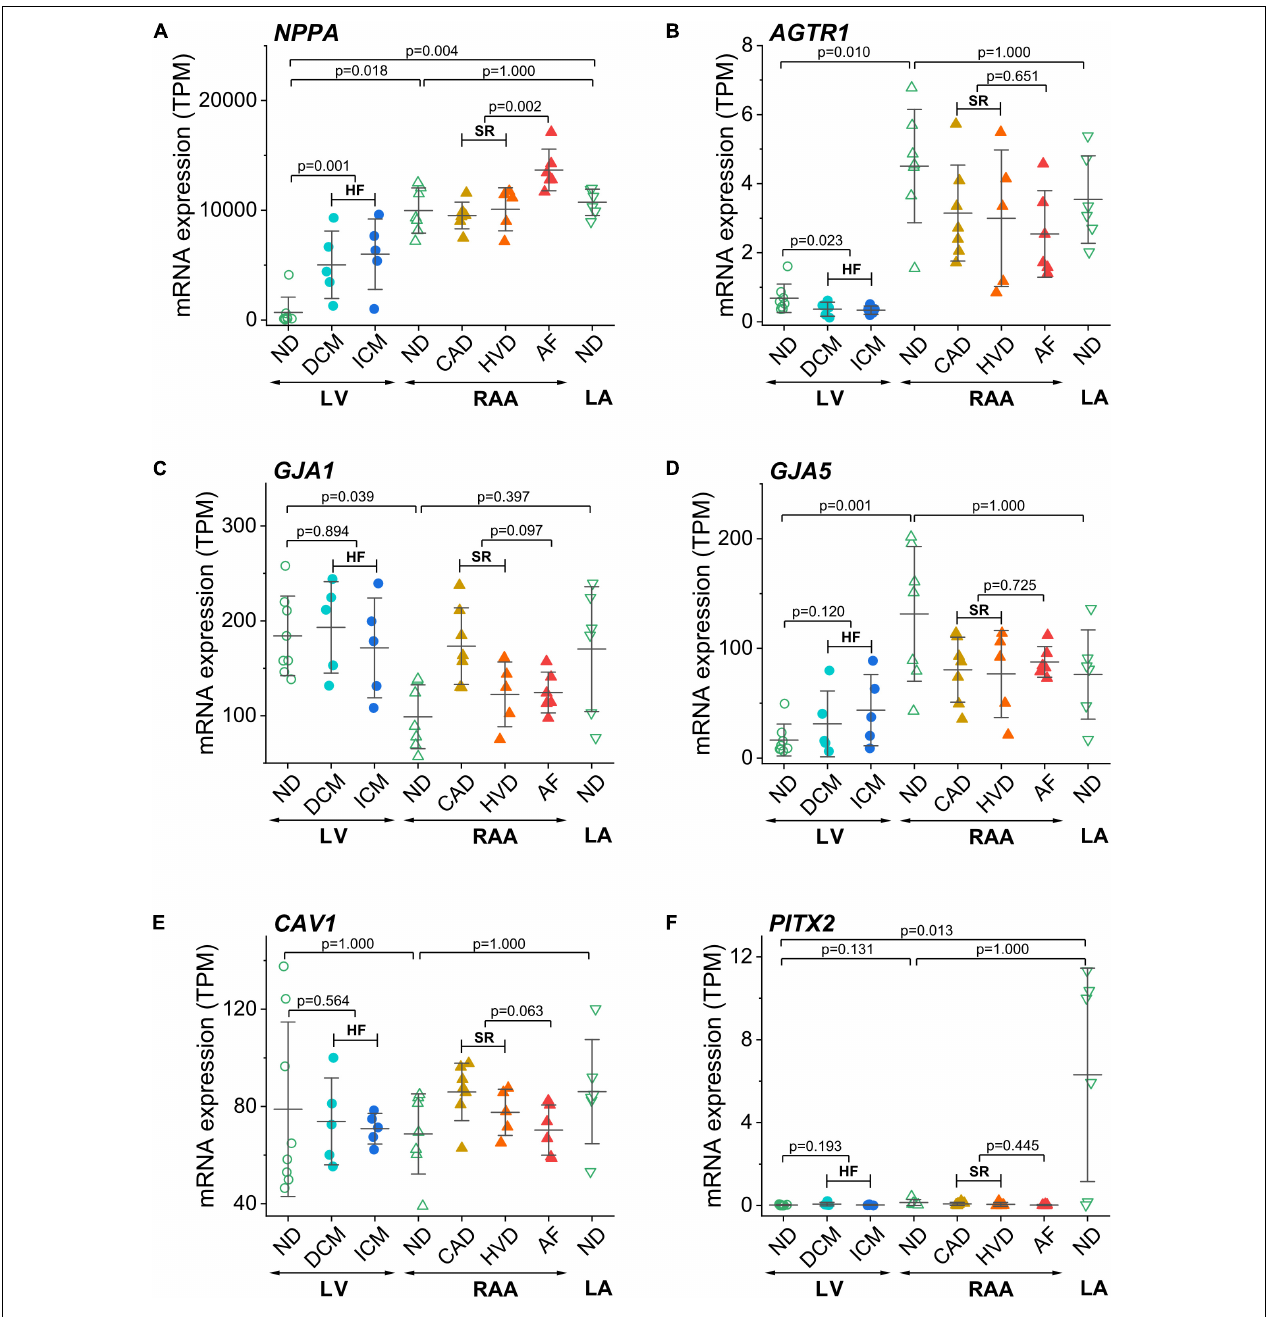
FIGURE 5 | Control of disease identity and reproducibility of known AF- or HF-related gene expression in transcripts per kilobase million (TPM) assessed by RNA-seq. (A) NPPA (atrial natriuretic peptide A), (B) AGTR1 (AT1 receptor or angiotensin II receptor type 1), (C) GJA1 (connexin-43), (D) GJA5 (connexin-40), (E) CAV1 (caveolin-1), (F) PITX2 (paired-like homeodomain transcription factor 2). Same layout as in Figure 3